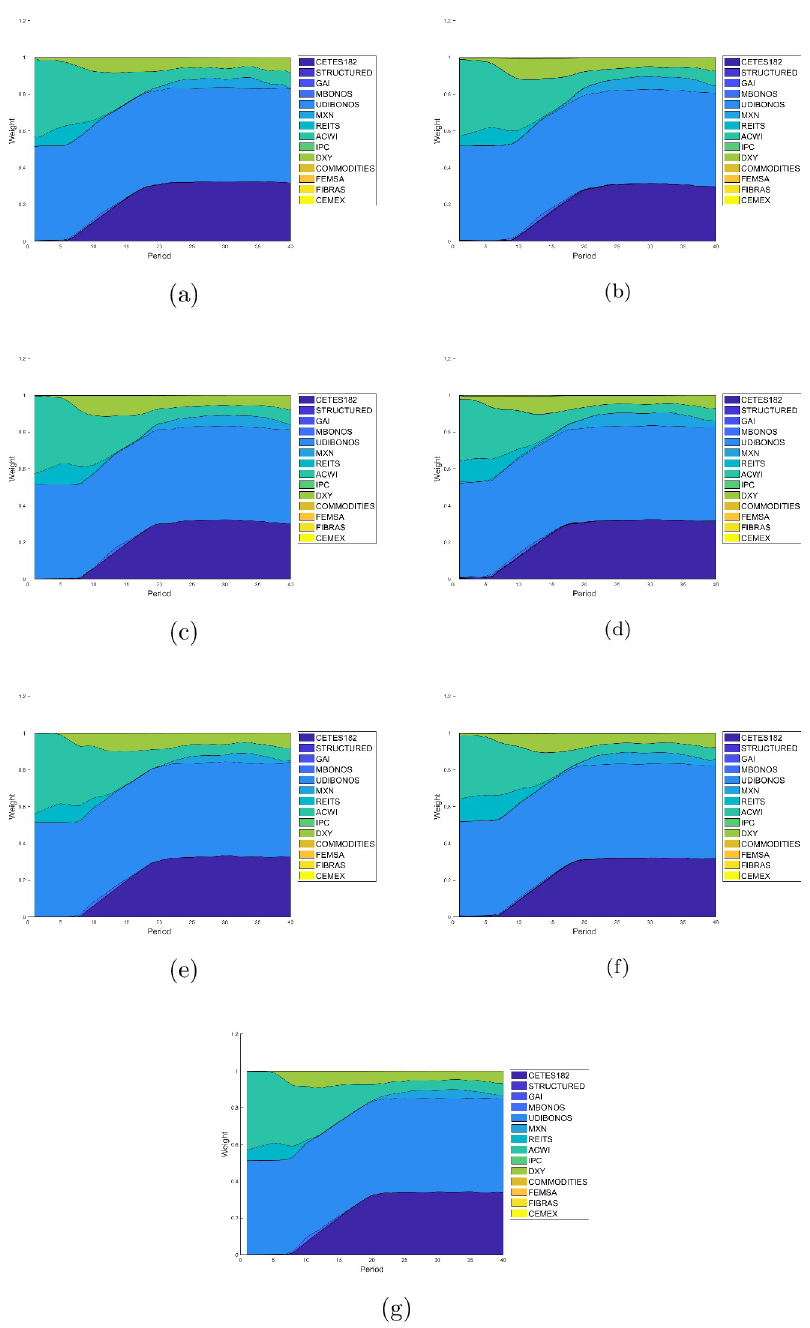
Fig 8. Allocation weights from the solution at the second quartile. (a) Case E1 with E { W ( T )}= 15.1176 and var { W ( T )} = 0.2502. (b) Case E2 with E { W ( T )} = 14.8490 and var { W ( T )} = 0.2436. (c) Case E3 with E { W ( T )} = 14.8487 and var { W ( T )} = 0.2652. (d) Case E4 with E { W ( T )}= 14.3866 and var { W ( T )} = 0.2111. (e) Case E5 with E { W ( T )}= 15.8739 and var { W ( T )} = 0.2179. (f) Case E6 with E { W ( T )}= 15.3782 and var { W ( T )} = 0.2436. (g) Case E7 with E { W ( T )}= 15.8740 and var { W ( T )} =